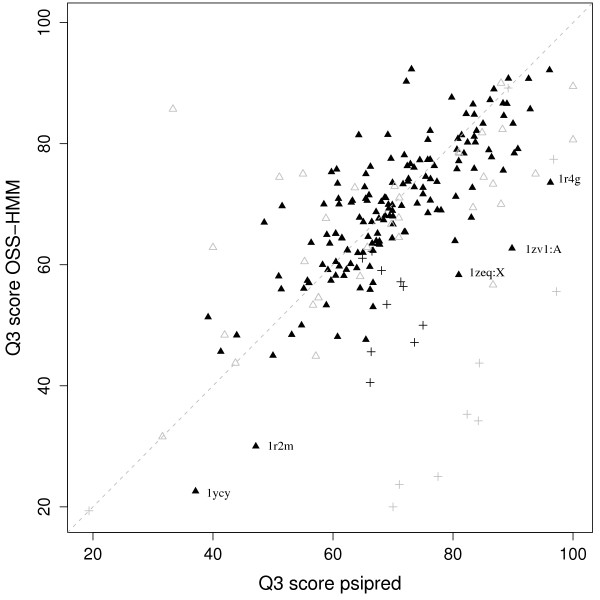
Q3 obtained for each protein of the EVA 212 dataset, by PSIPRED and OSS-HMM. Globular proteins are shown as triangles and membrane proteins as crosses. Proteins shorter than 50 residues are indicated with gray symbols. The diagonal where both PSIPRED and OSS-HMM Q3s are equal is shown as a dashed line. OSS-HMM refers to the HMM presented in this article.